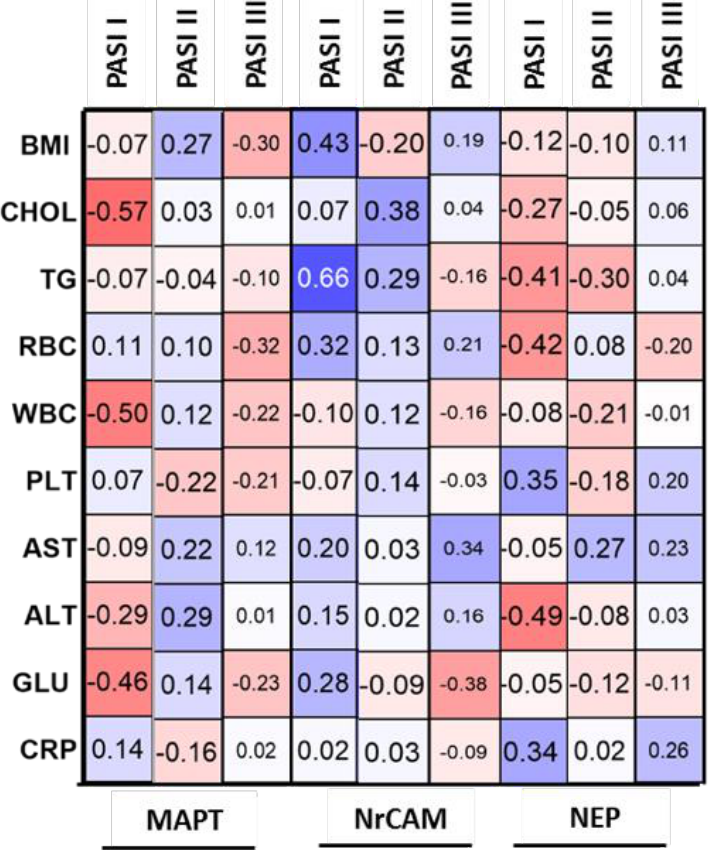
Figure 2. Correlations between evaluated proteins and selected laboratory parameters with regard to PASI subdivision before total treatment with use of Spearman’s rank correlation. In patients with mild psoriasis, MAPT correlated negatively with total cholesterol, WBC and glucose levels (Figure 2). Further, in patients of normal weight significant negative correlations between the MAPT and WBC or PLT were noted (Figure 3). In overweight psoriatics MAPT was significantly positively correlated with total cholesterol concentration and in obese—negatively with TG (Figure 3). The duration-based division of the patients group with a threshold of 20 years showed that the duration of psoriasis does not influence significantly MAPT level (Figure